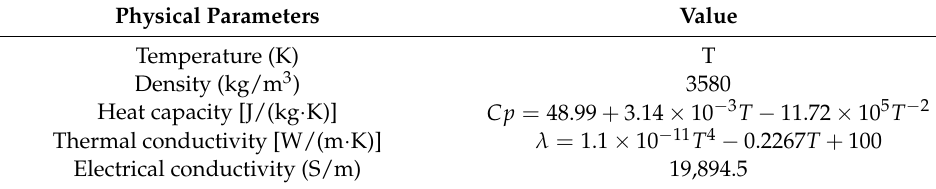
Table 3. Physical parameters of magnesium oxide.